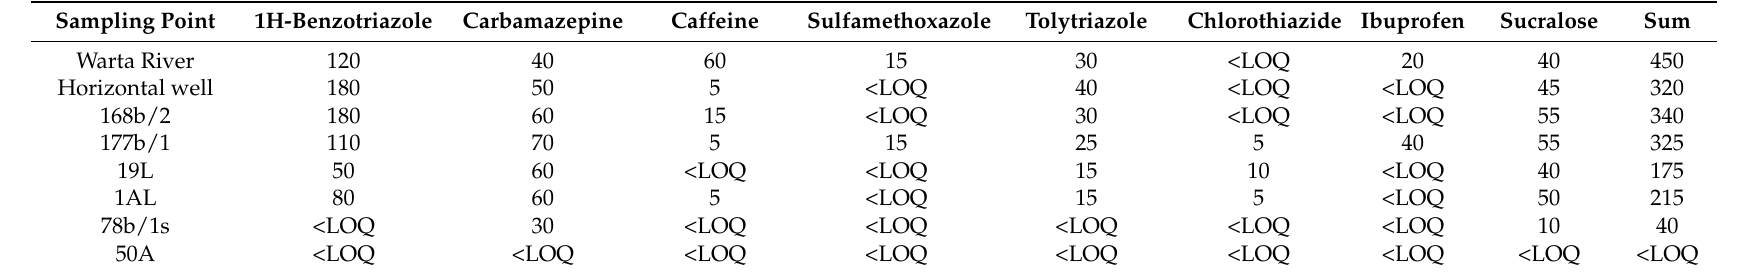
Table 2. Concentration of relevant pharmaceuticals and other micropollutants in ng/L (Limit of Quantification (LOQ) < 5). Sampling